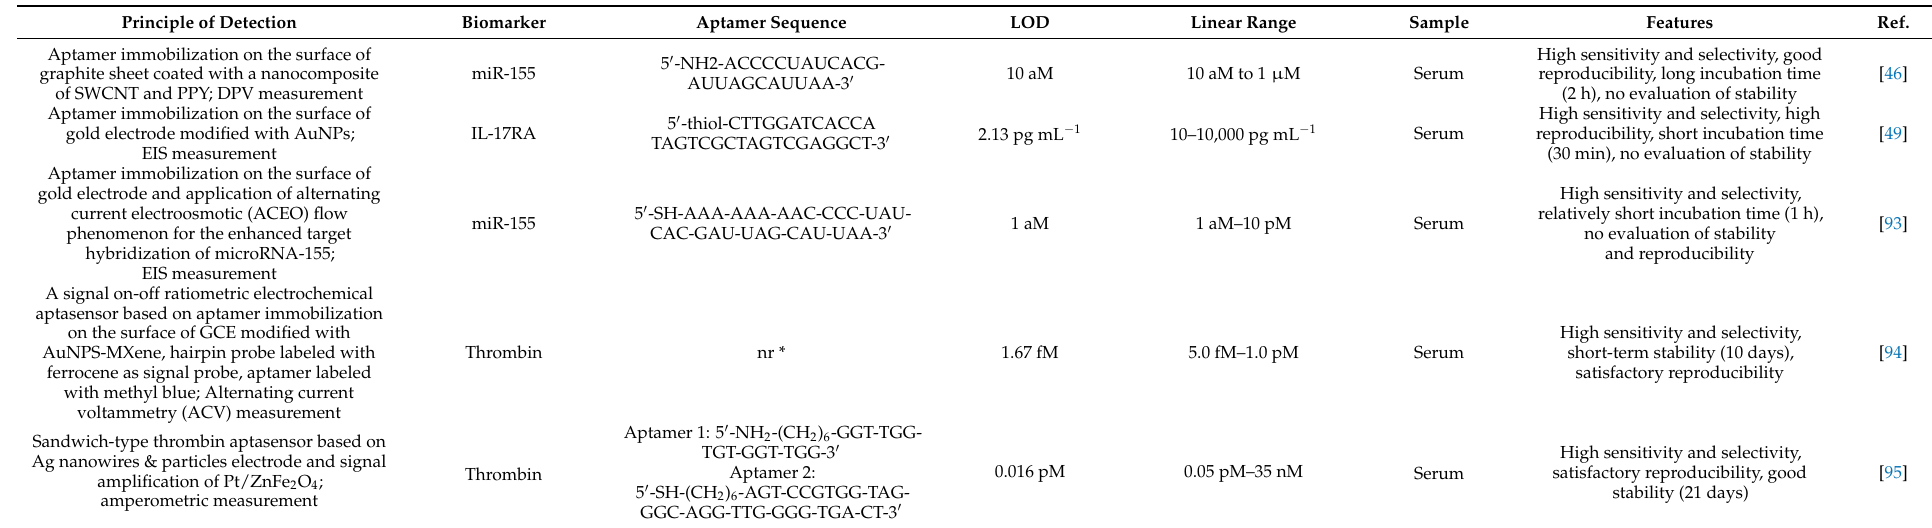
Table 4. Recent advances in electrochemical aptasensors for the detection of MS biomarkers.